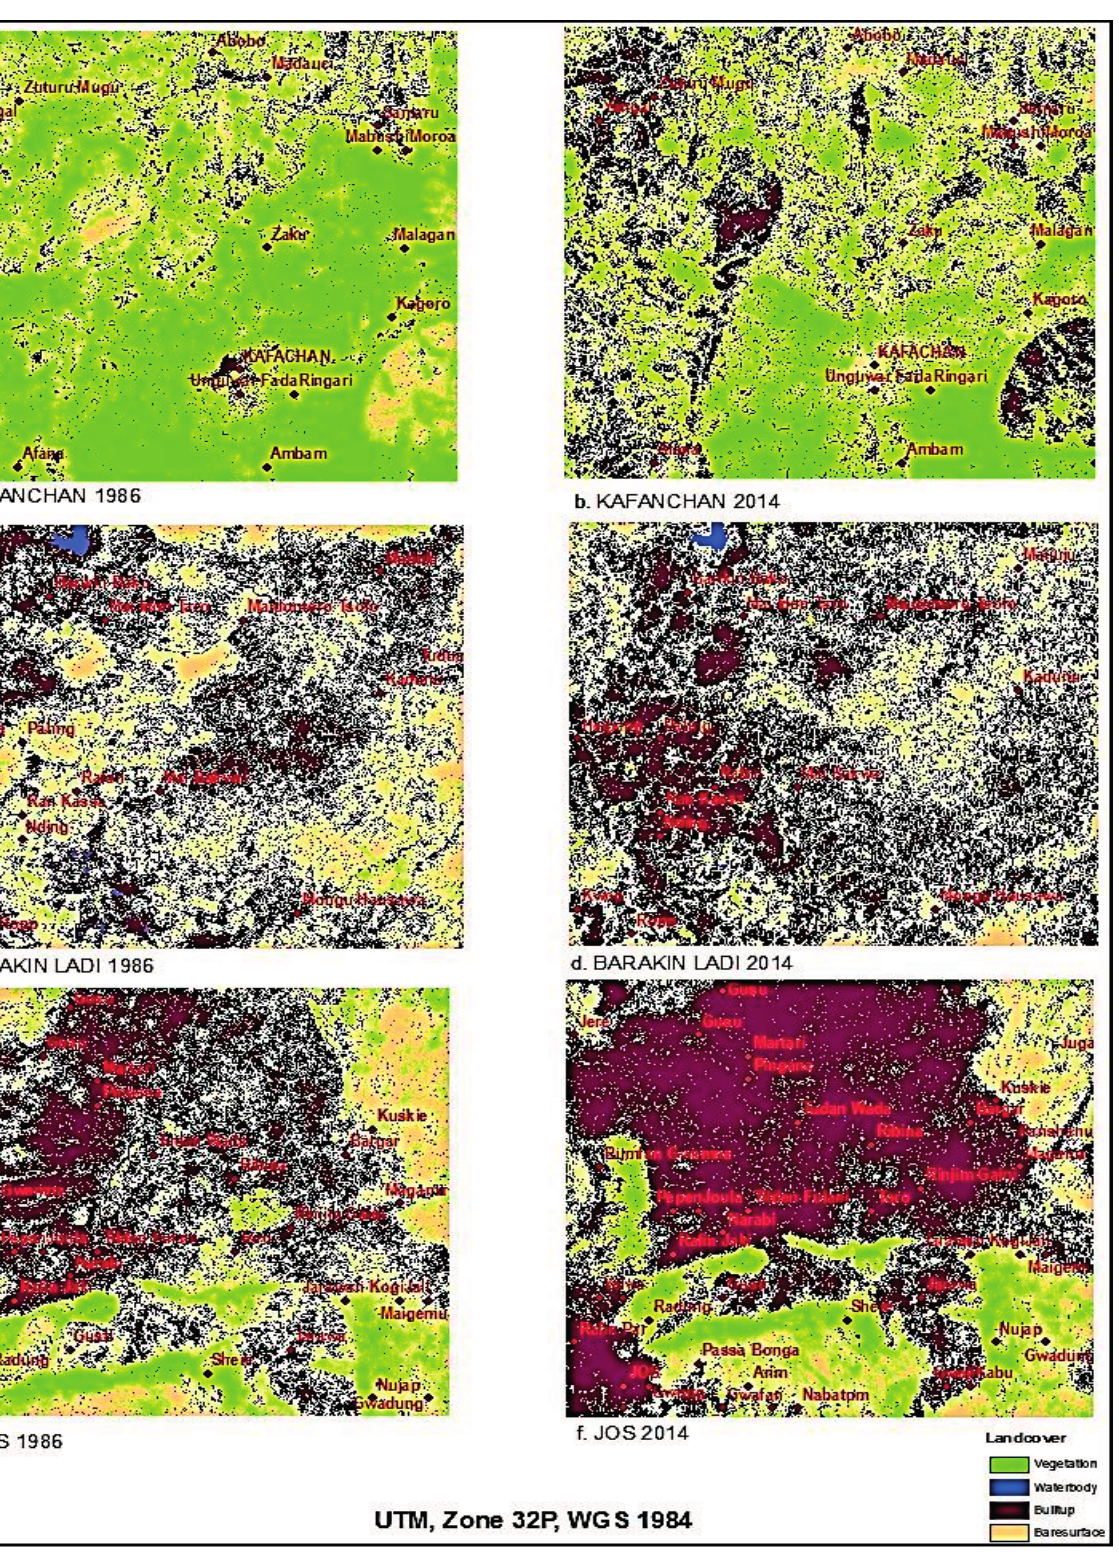
Figure 4. Landcover change in the three